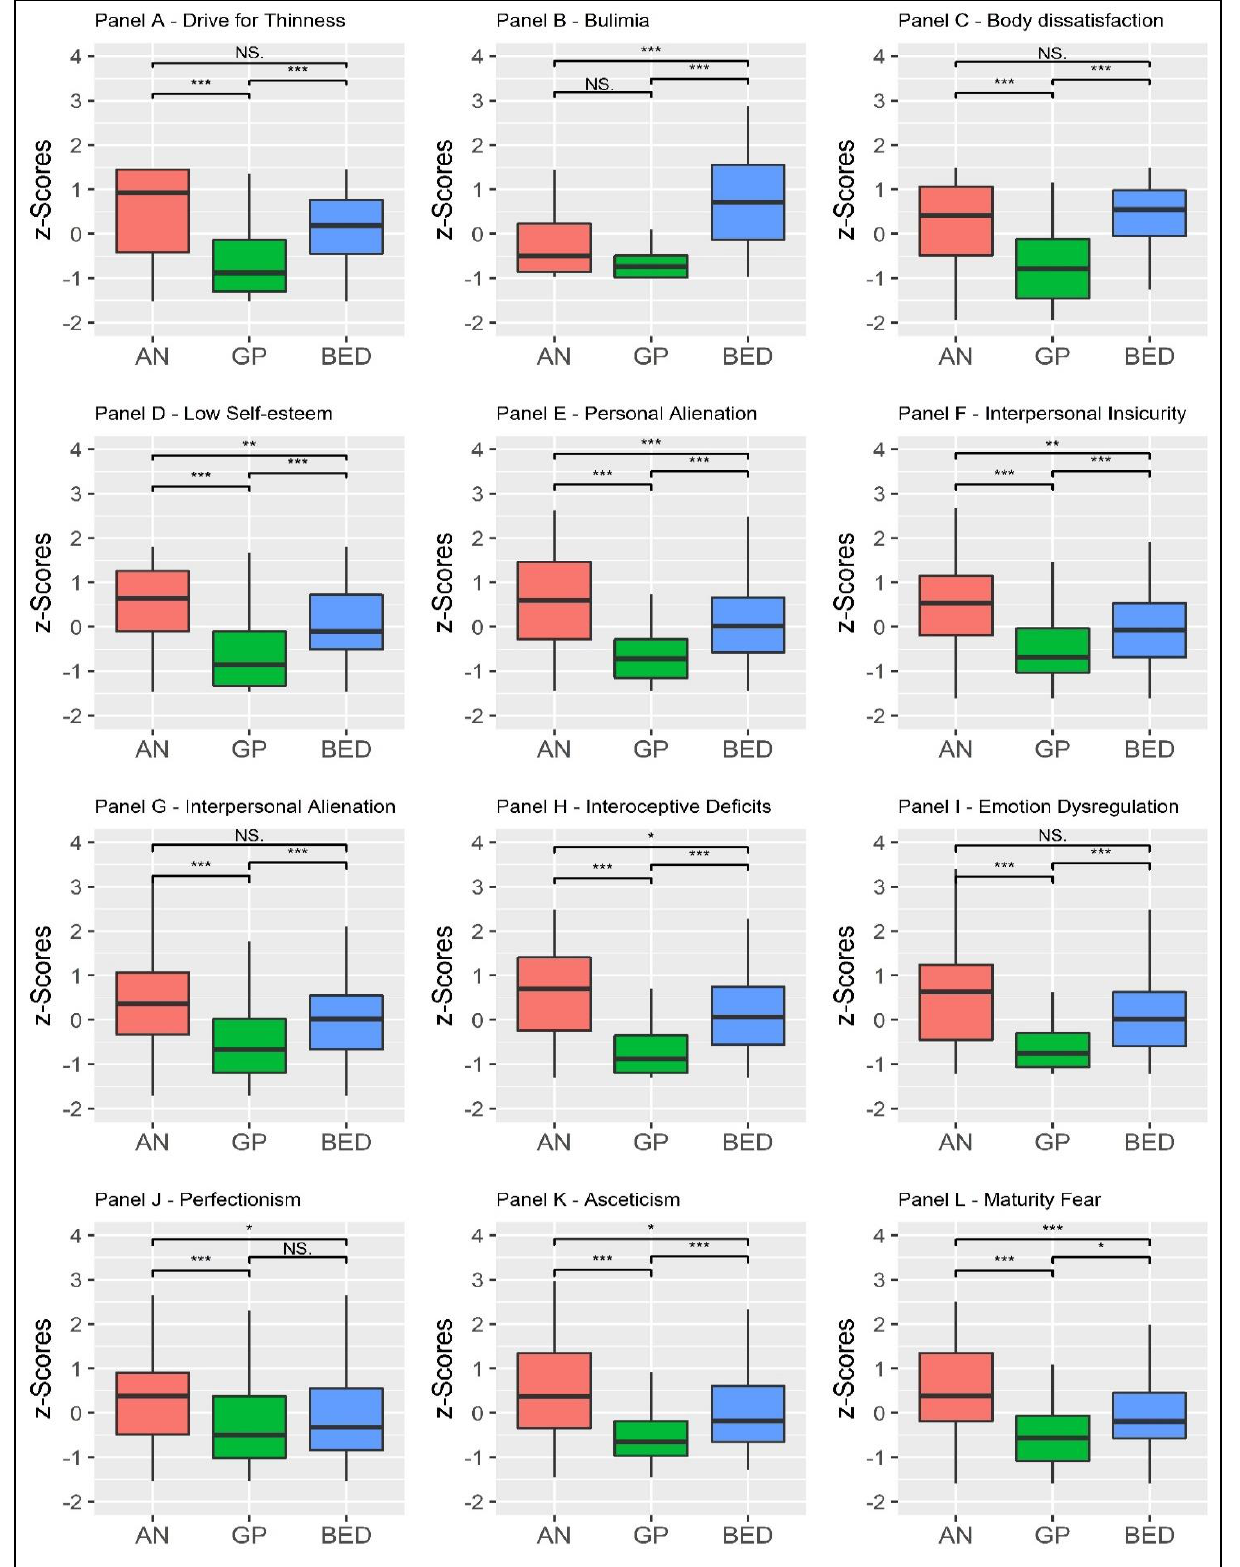
Figure 2. Between-group means comparison. Values are expressed as z-scores. Note : * p bonf < 0.50; ** p bonf < 0.010; *** p bonf < 0.001. AN = participants with anorexia nervosa ( n = 142); BED = participants with binge eating disorder ( n = 139); GP = participants from the general population ( n = 140).